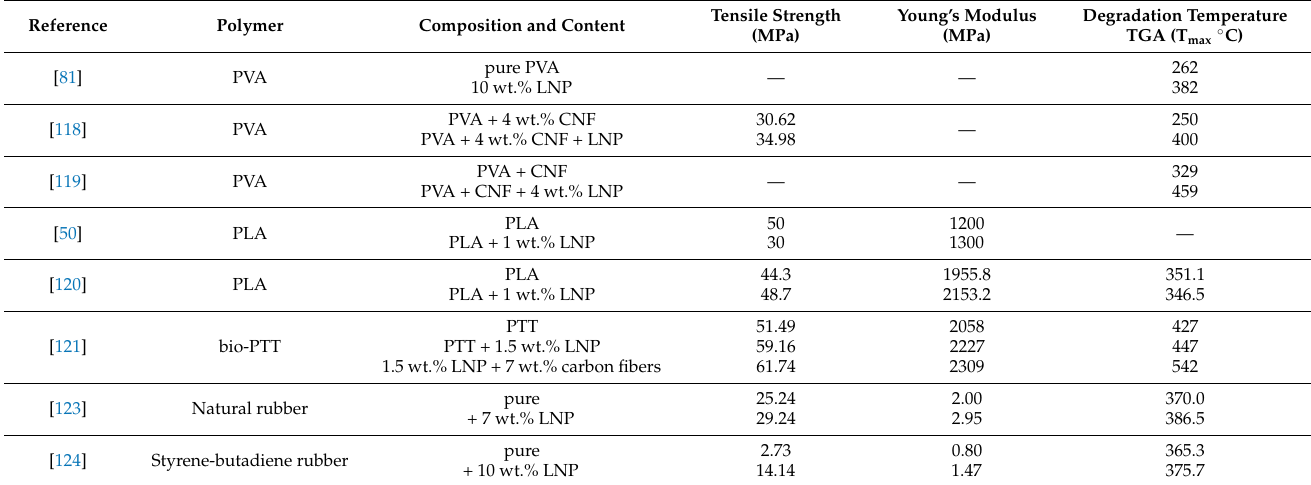
Table 7. Mechanical properties and degradation temperature of different polymers and their nanocomposites.